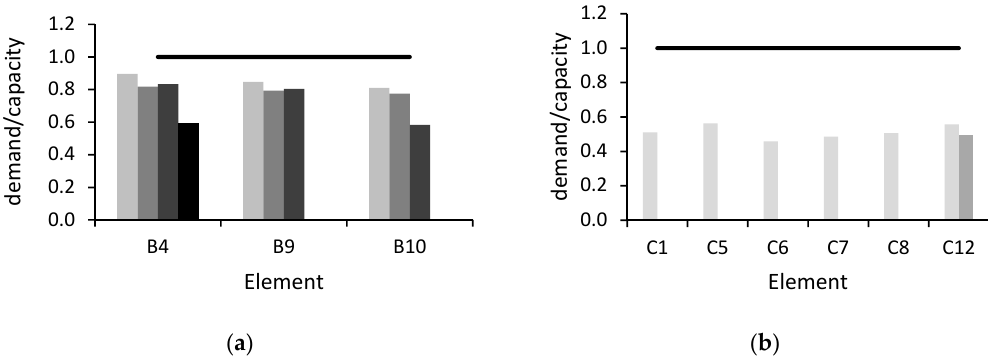
Figure 11. Ductile verifications after retrofit of: ( a ) beams and ( b ) columns.